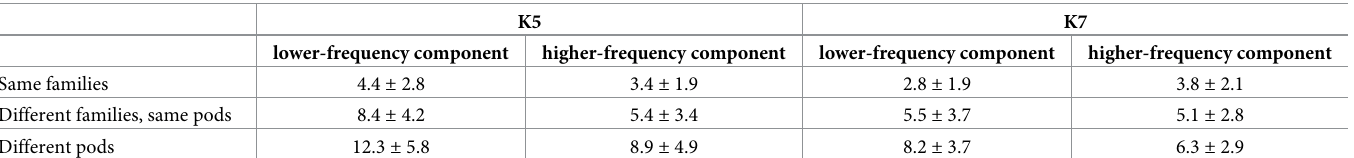
Table 1. Distances (mean ± SD) between pairs of calls calculated through dynamic time warping for lower- and higher-frequency components of K5 and K7 call types between the same families, between different families from the same pods, and between different pods.